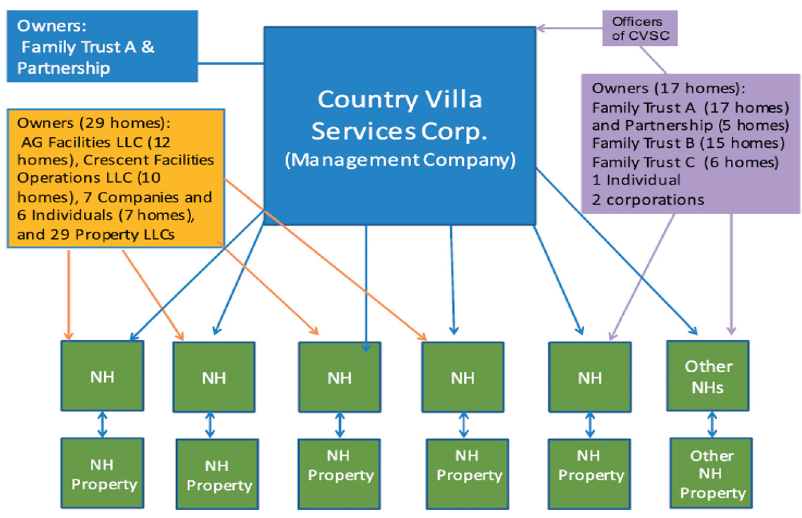
Figure 1: Country villa services corporation structure. (Reprinted from Harrington, Ross, and Kang